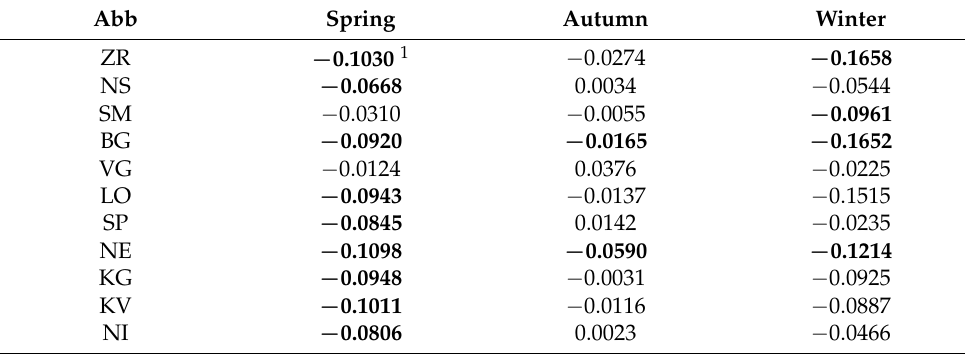
Table 5. Seasonal trend coefficients of FD for 11 stations in Serbia from 1949 to 2018. Abb